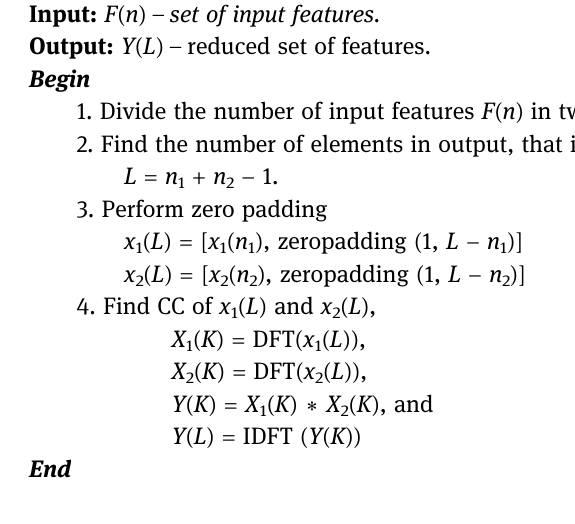
Algorithm 1. Feature reduction using the LC equivalence method.